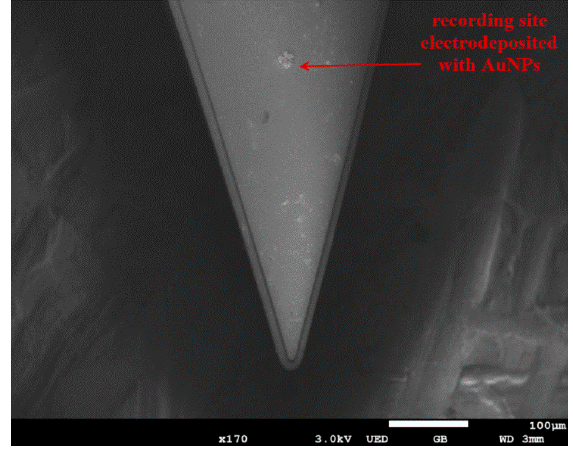
Figure 7. SEM images of tip of microelectrode shank.